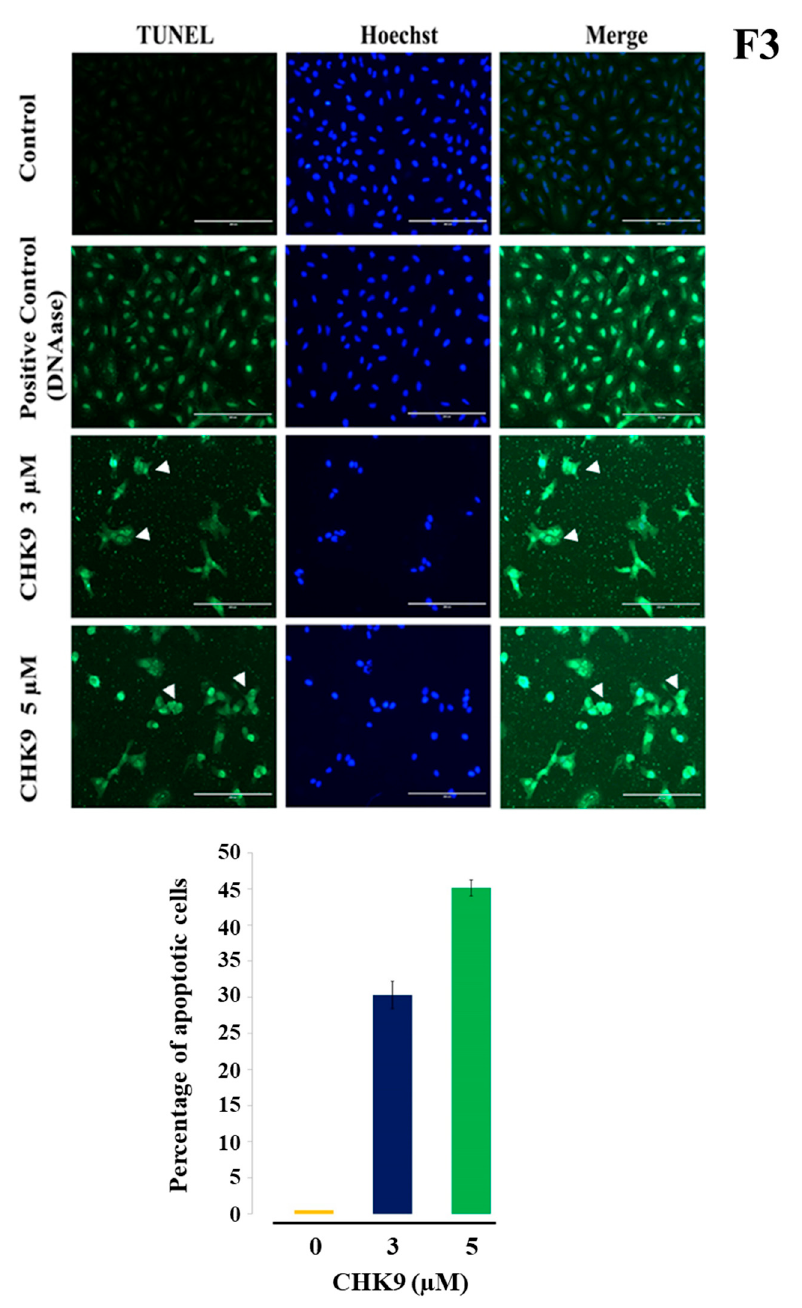
Figure 3. CHK9 increases TUNEL-positive cells. The A549 cells were treated with CHK9 at 0, 3 and 5 µ M for 48 h and used for TUNEL assay. Hoechst staining is used for staining the nucleus. DMSO / DNase / CHK9-treated cells were photographed, quantified, and expressed in the form of a bar graph (Magnification: 20 × ). TUNEL-positive cells were indicated using white arrowheads.